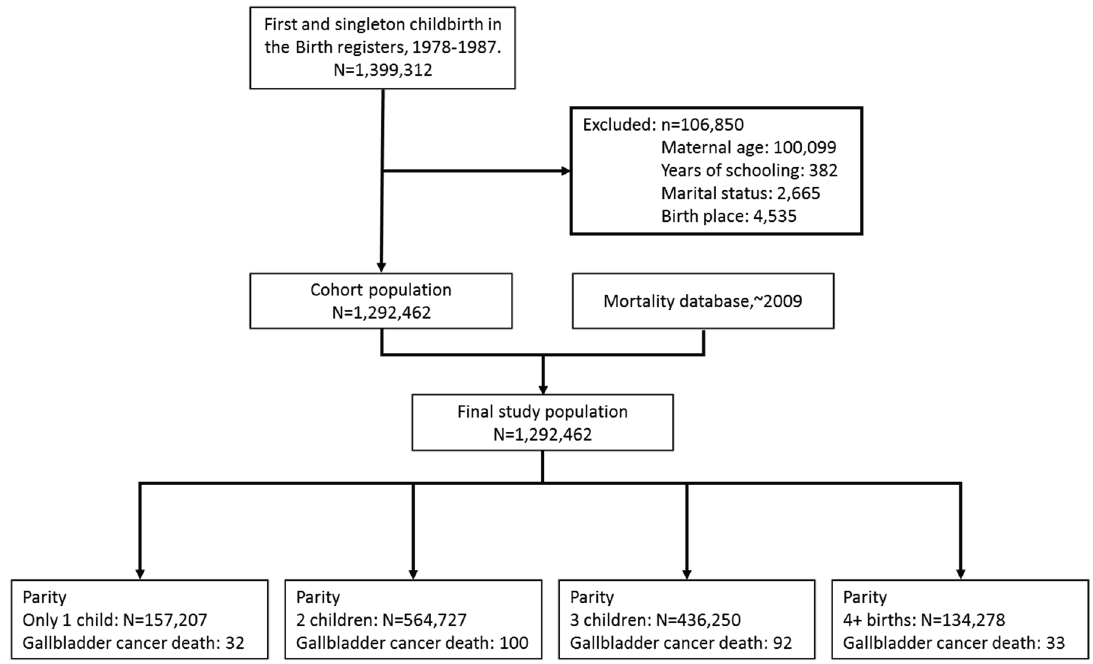
Figure 1. Flowchart of study subject